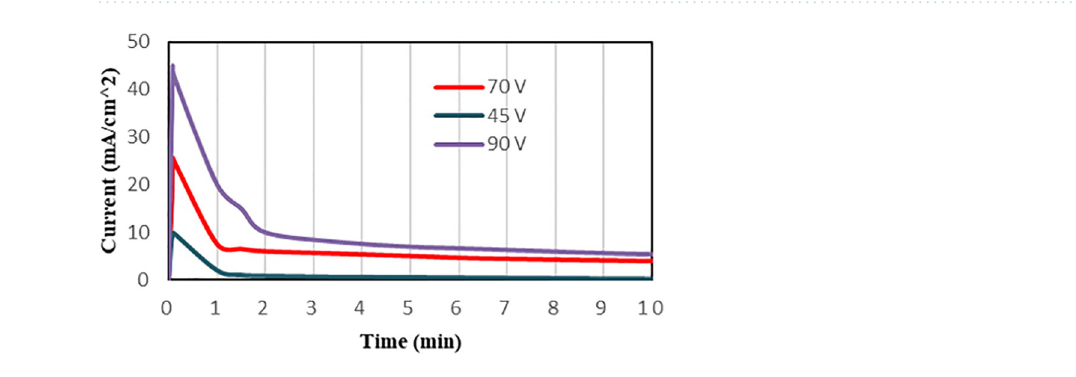
Figure 3. Transient curve at voltages of 45, 70, and 90 V for 3 h (4